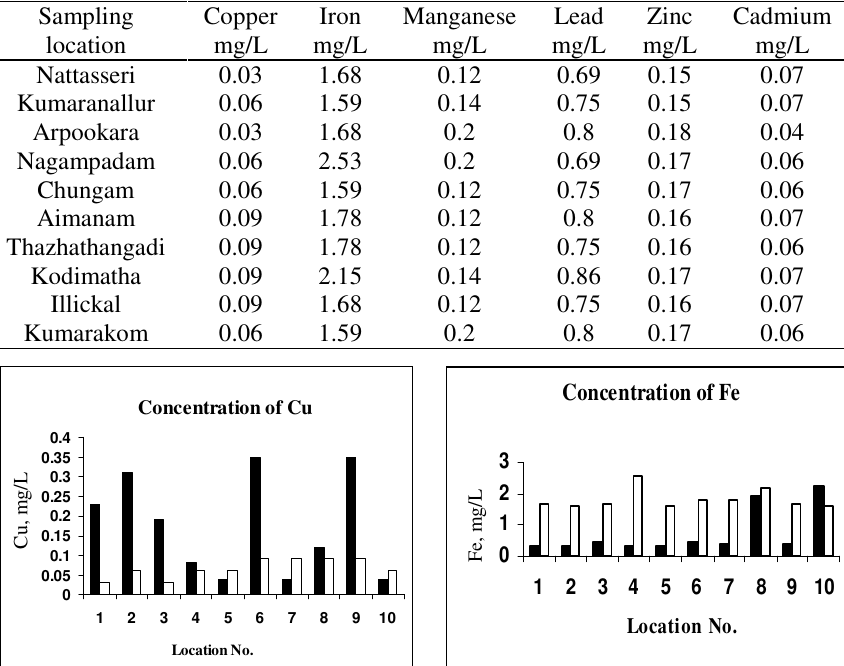
Table 3. Trace metal content of Meenachil river at Kottayam during Post-monsoon